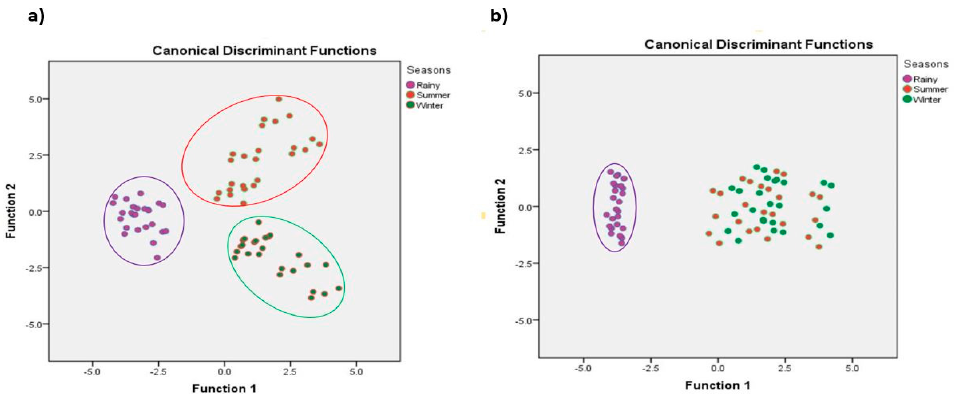
Figure 6. Discriminant function analysis for the antioxidant molecules of P. globosa . Discriminant